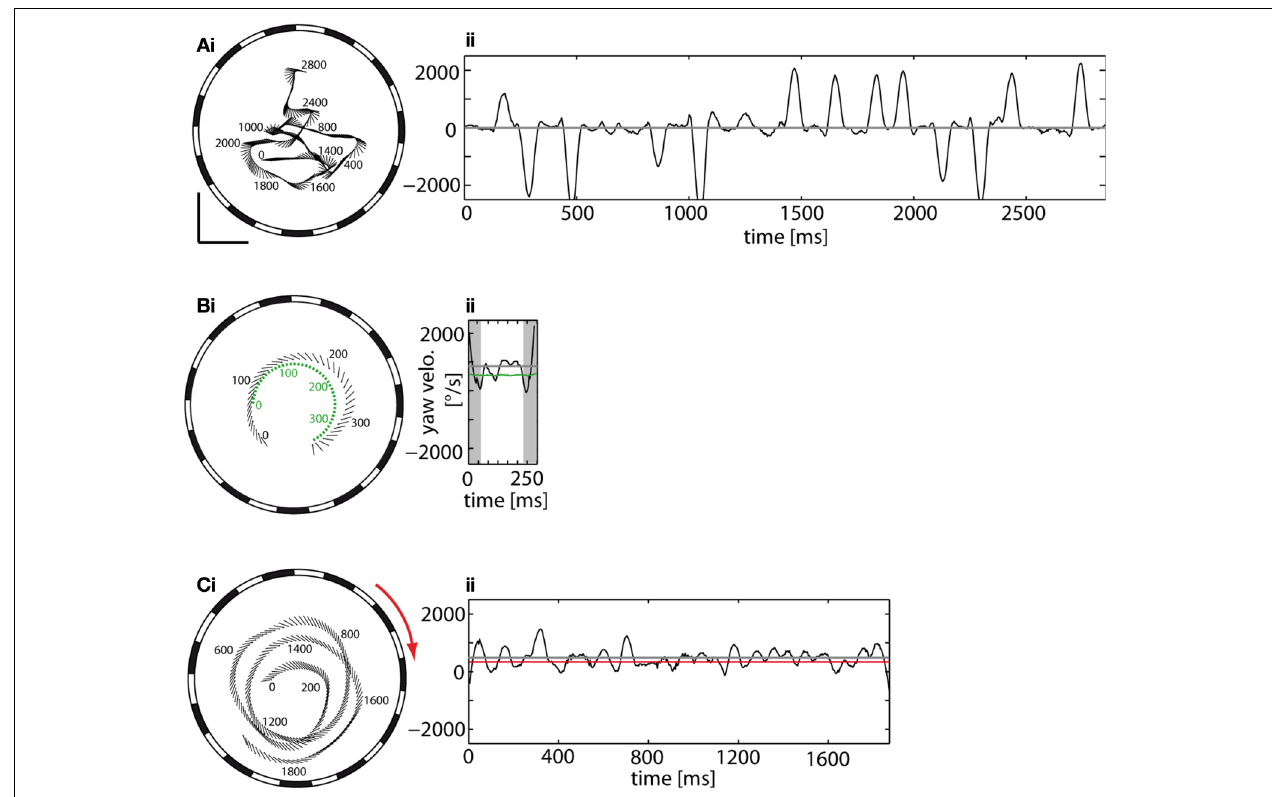
FIGURE 2 | Flight trajectories of male fl ies, as seen from below, and time-dependent yaw velocities of (A) a cruising fl ight, (B) a chasing fl ight and (C) an optomotor fl ight. (Ai) Flight trajectory of a male fl y cruising in the arena that is surrounded by a stationary background (vertical grating). Numbers denote time (in ms) with respect to the beginning of the trajectory. (Aii) The yaw velocity profi le of the fl y refl ects the saccadic fl ight style characteristic of cruising fl ights. Between the turns exceeding 2500 ° /s are time intervals with little or no rotation. (Bi) Flight trajectory of a fl y ( black ) chasing the target ( green ) which moved on a circular track. The position ( centroid ) of the fl y is depicted by a dot , the orientation of its body long axis by the line . The fl ight arena is surrounded by a